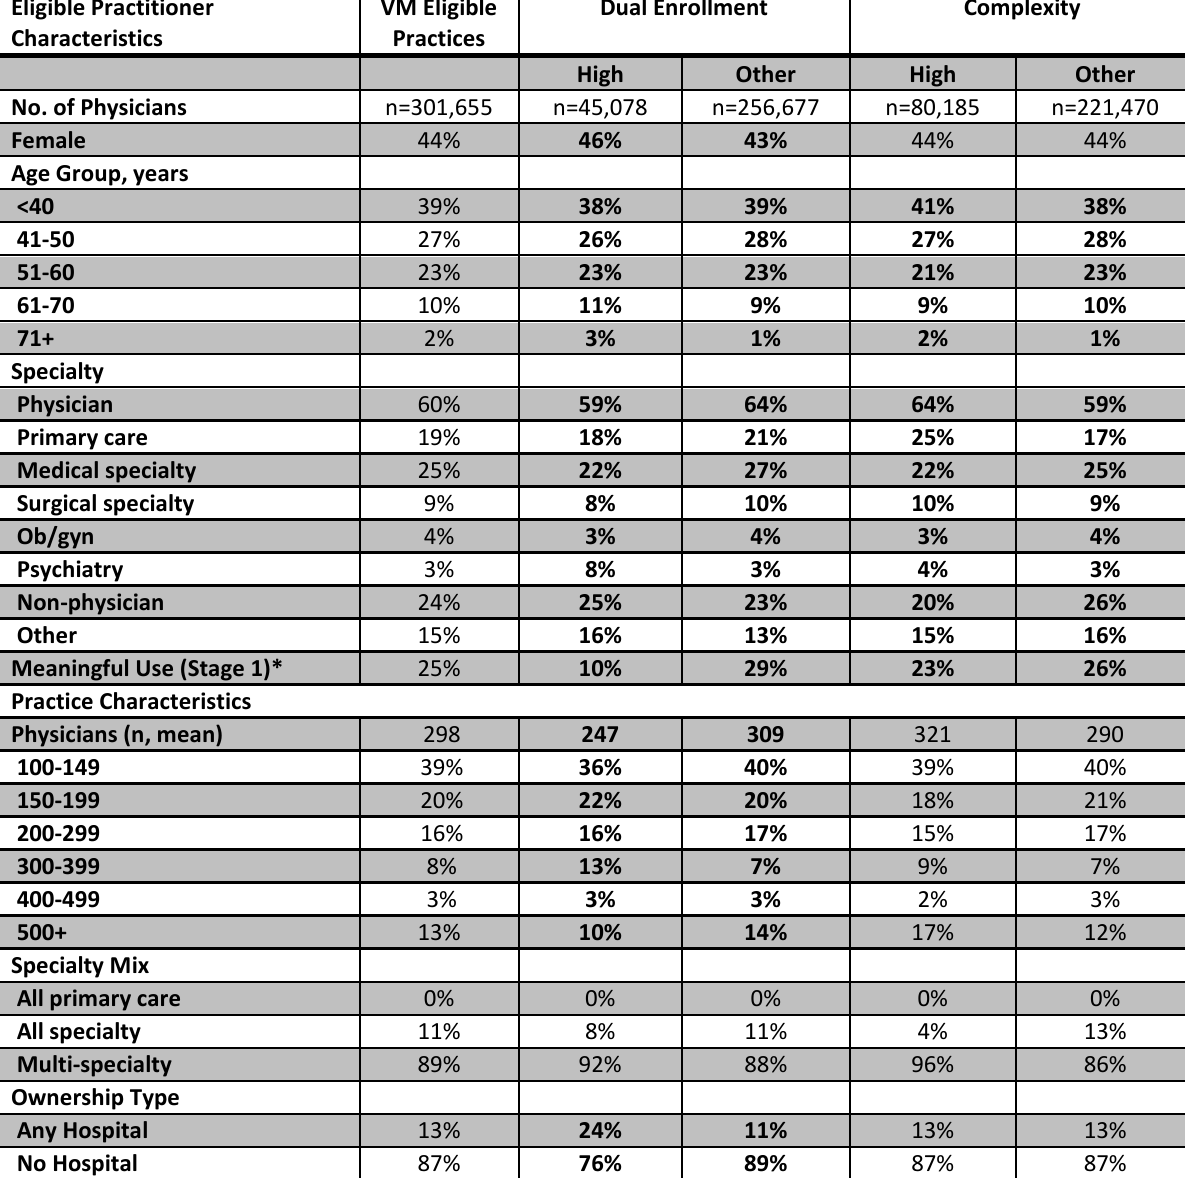
Table 10.4. Characteristics of Physicians and Practices Caring for a High Proportion of Dually-Enrolled or Complex Beneficiaries, Compared to Other Physicians and